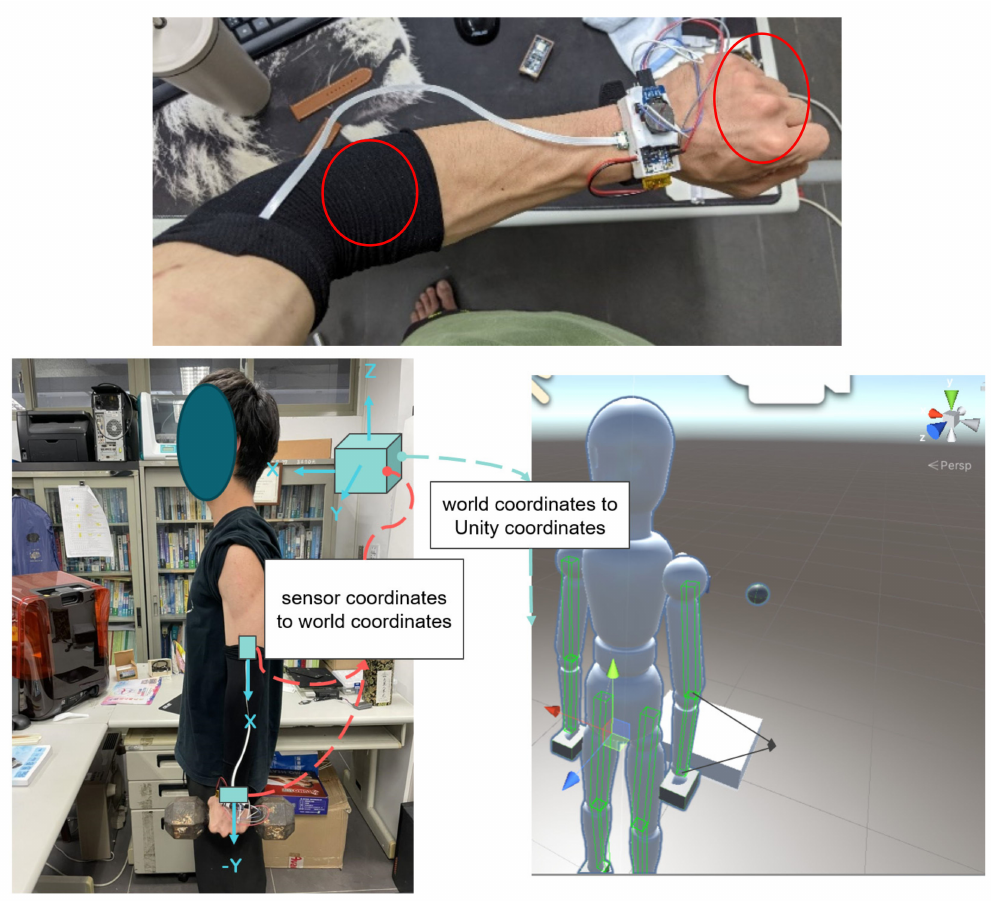
Figure 3. 3D coordinate conversion flowchart: ( top ) wearable device, ( bottom left ) sensor coordinates to world coordinates, ( bottom right ) world coordinates to Unity